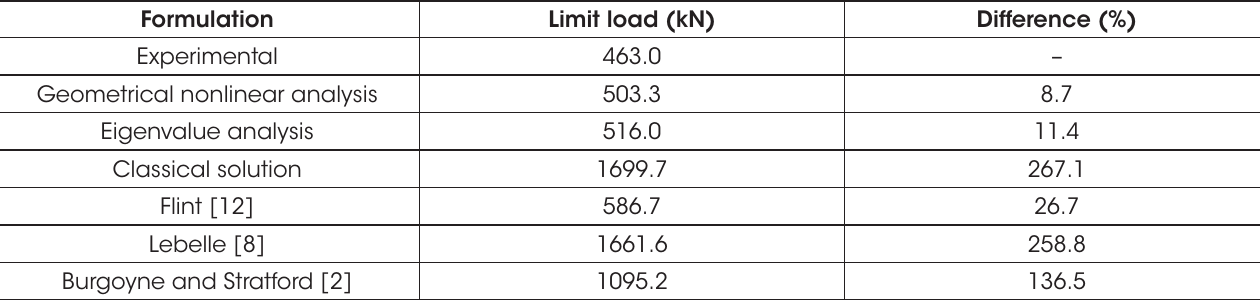
Comparison of instability load for the beam PCI BT-54 Formulation